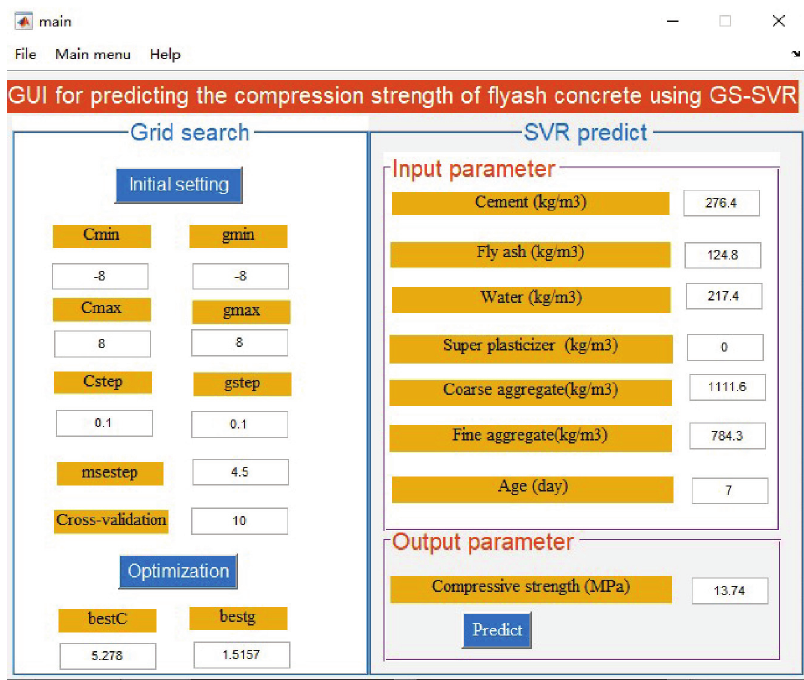
Figure 10: GS-SVR model-based interactive graphical user